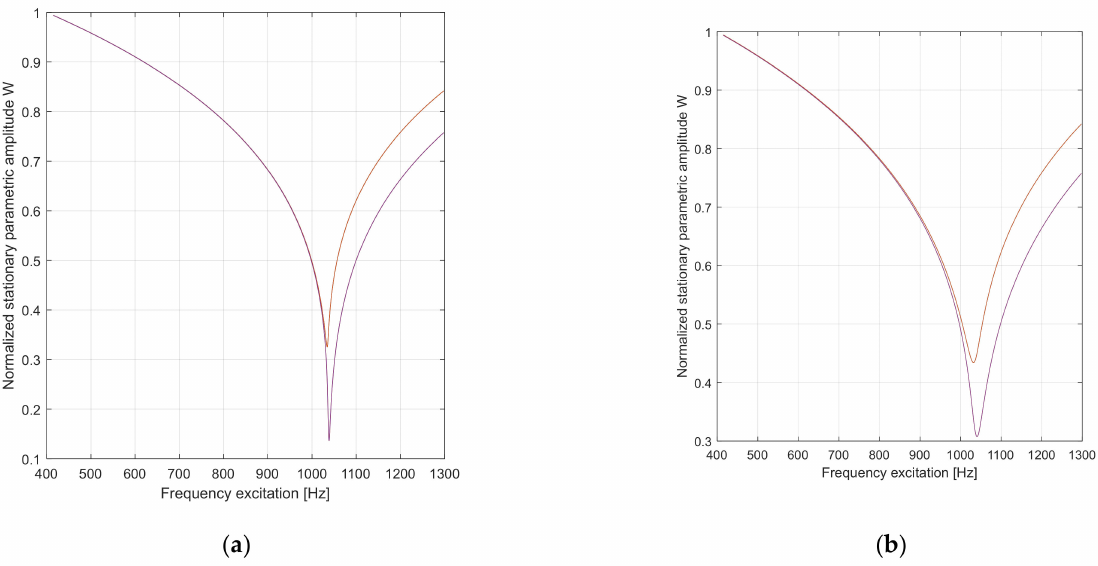
Figure 11. Normalized stationary parametric amplitude W of the tulip for χ nT = 0.25, where µ = 0.623 × 10 − 4 . ( a ) ζ = 0.0016. ( b ) ζ = 0.0116.